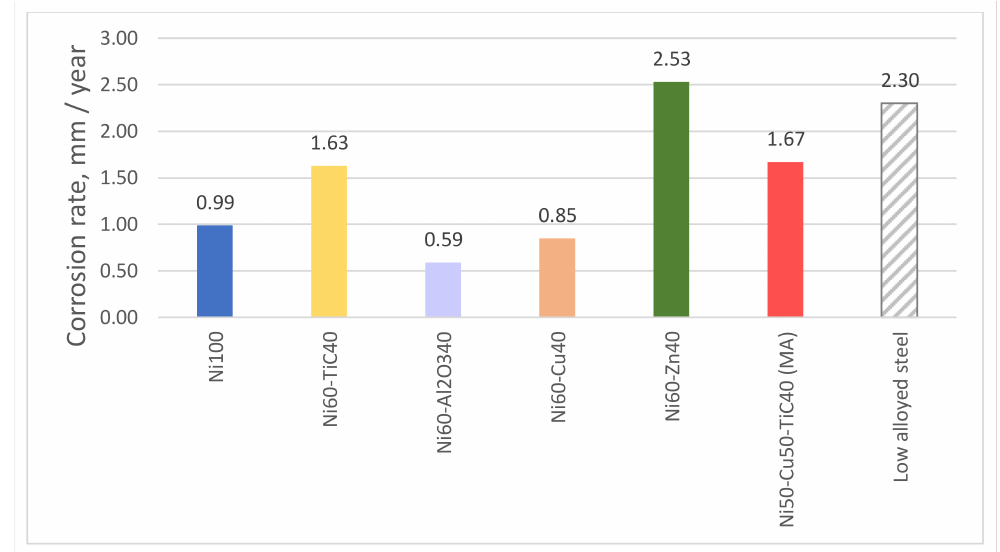
Figure 9. Corrosion rate (in mm per year) of the nickel coatings calculated using electrochemical tests in a 3% NaCl solution with pH = 2.5 [37].